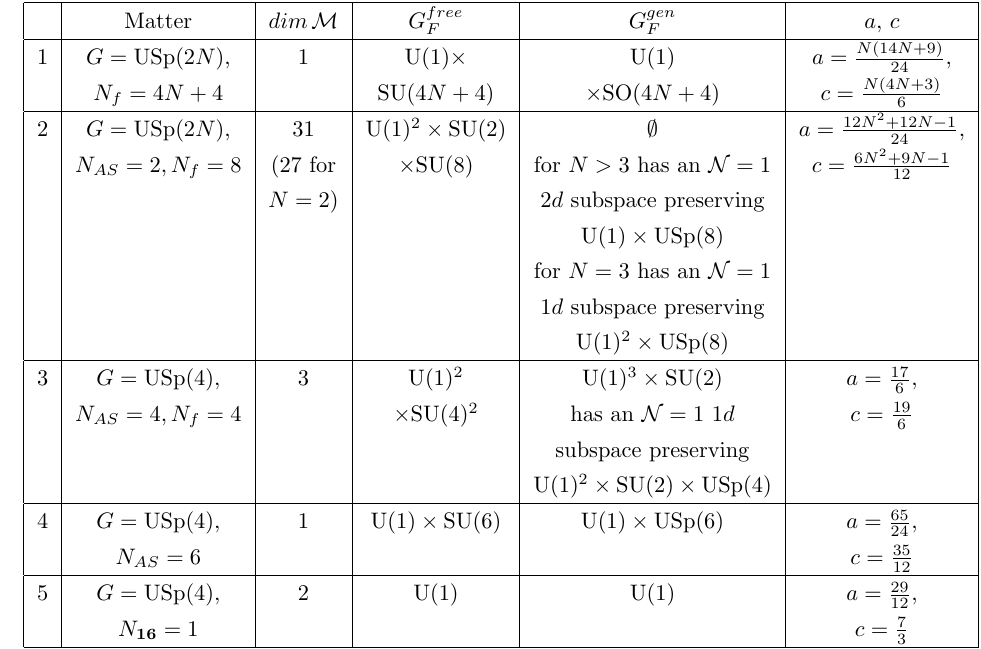
Table 28 . Cases involving a USp(2 N ) gauge group with extended supersymmetry. All cases also have an adjoint chiral (cid:12)eld in addition to the matter written in the